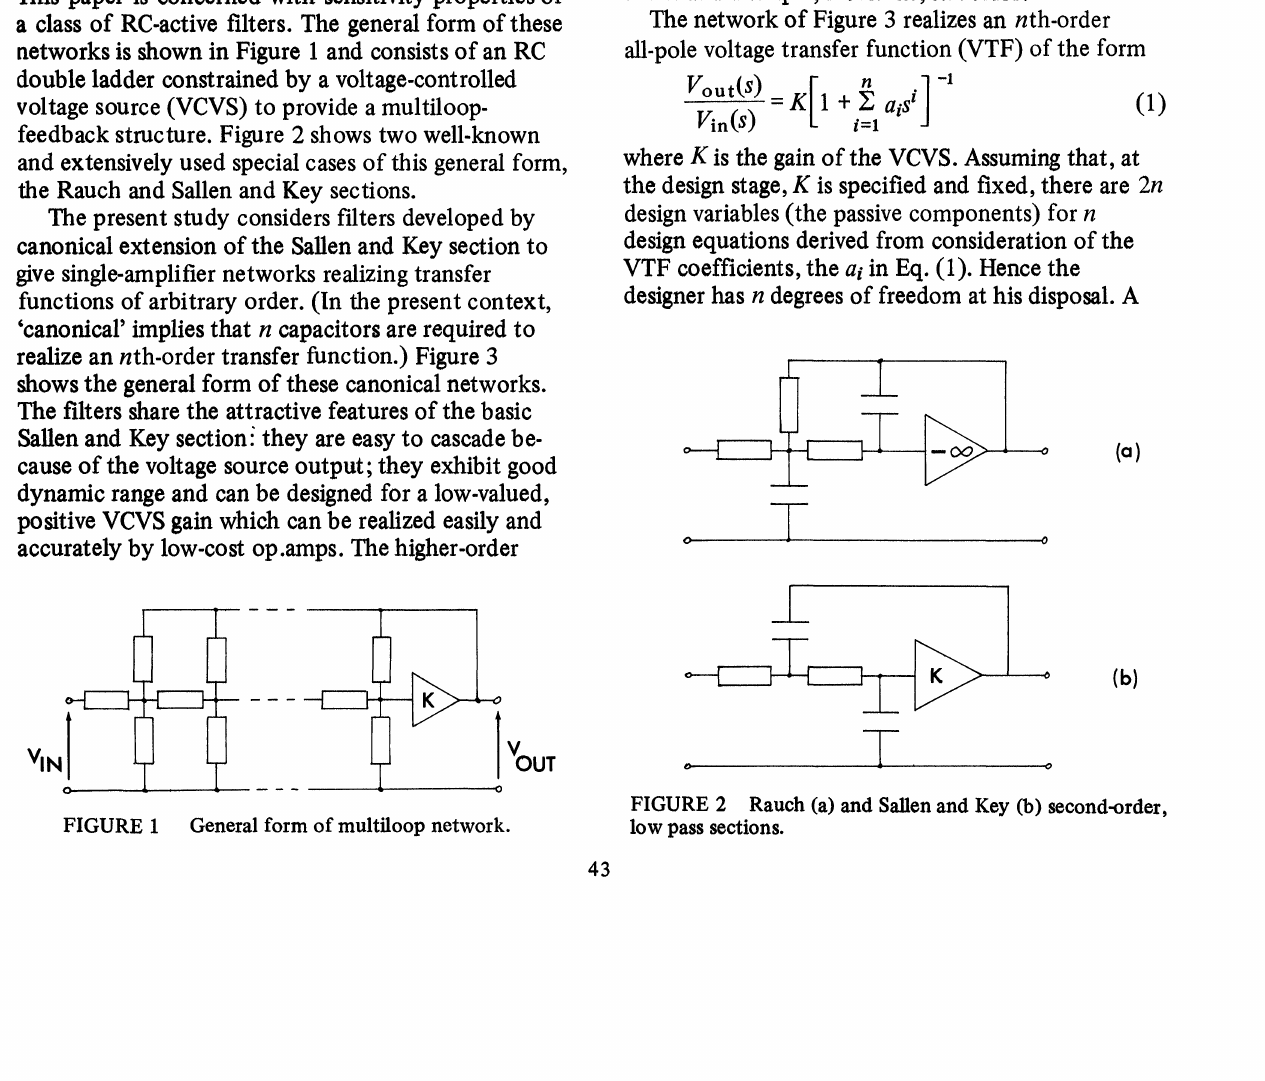
FIGURE 2 Rauch (a) and Sallen and Key (b) second-order, low pass